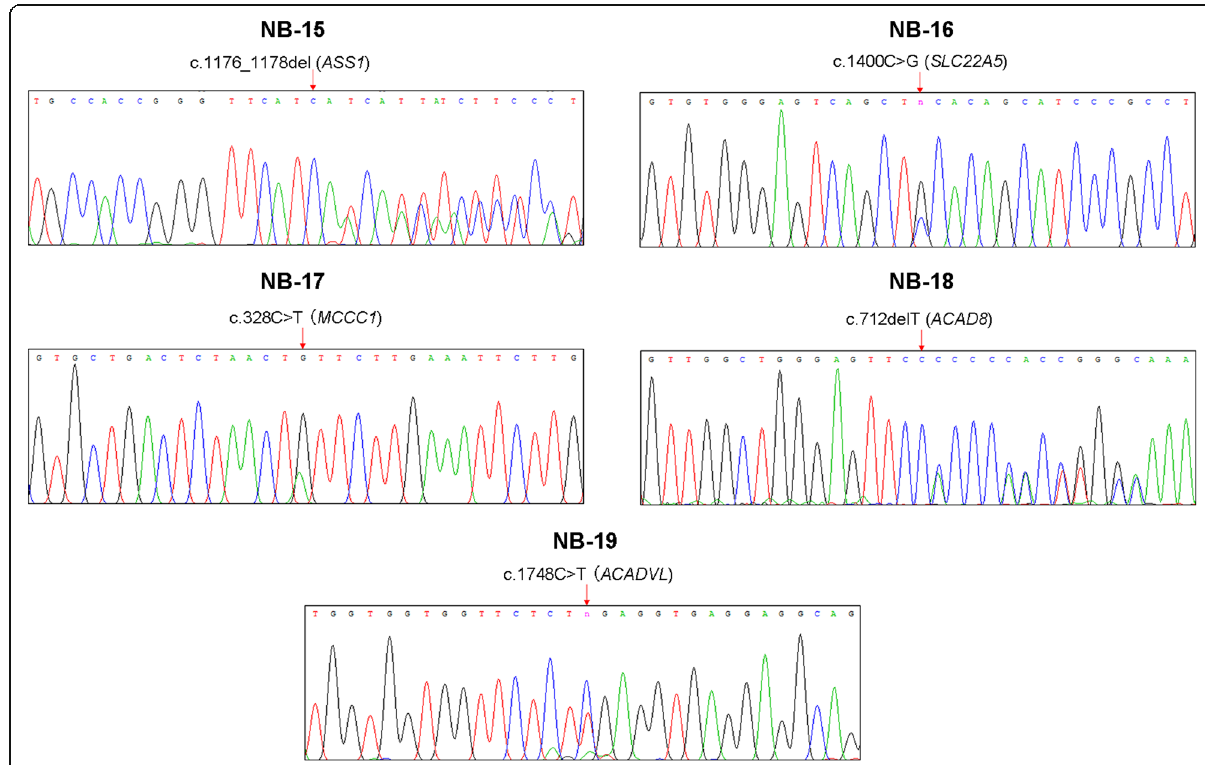
Fig. 4 Sanger sequencing confirmation of IEM DNA variants detected in 5 newborns diagnosed with as normal (false